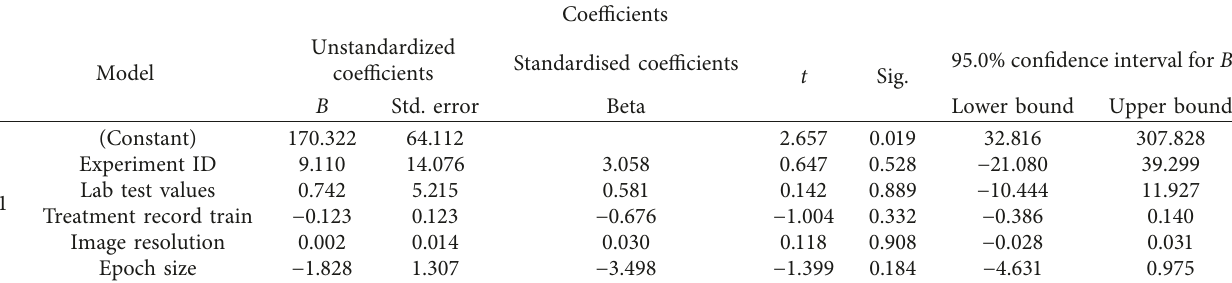
Table 2: Regression analysis 1.